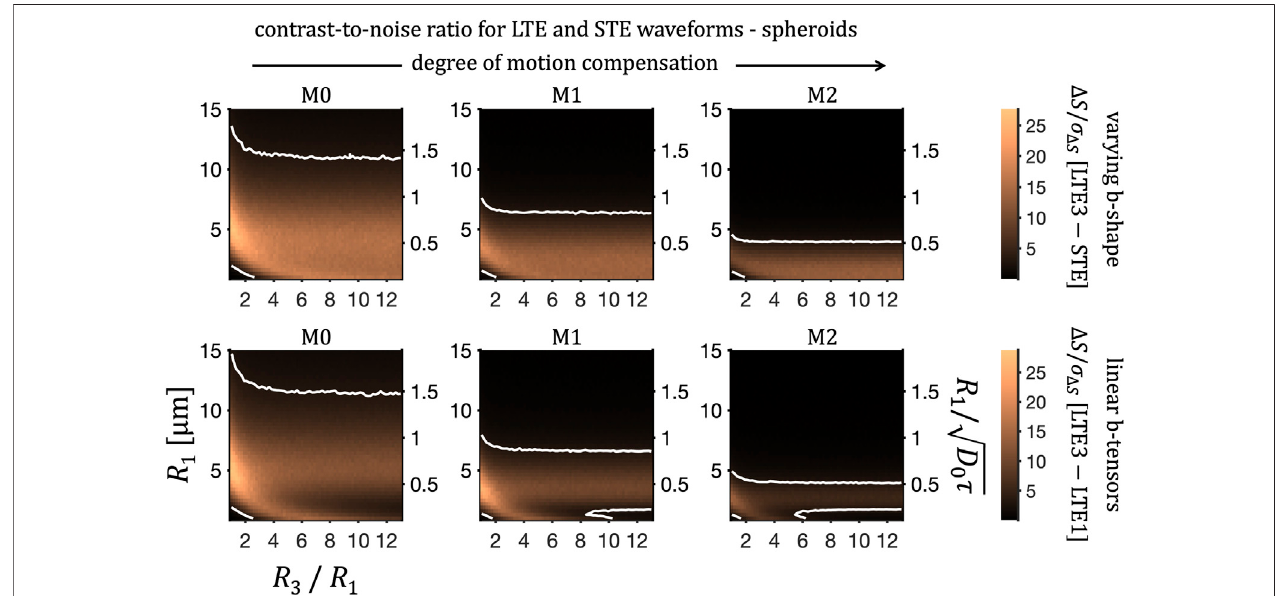
FIGURE 13| Size sensitivity for spheroidalporesat SNR =50. Contrast-to-noise ratio, Δ S / σ Δ S at b = 2 ms/ μ m 2 (as in Figure 12 ) and for f R = 0.5 is shown for M0-, M1-, and M2- (left to right) LTE and STE waveforms as a function of semi-axis R 1 = R 2 and ratio R 3 / R 1 . Two common colour scales are used to show contrast-to-noise ratios for rotation-averaged signals from LTE3 and STE (top row) and from LTE1 and LTE3 (bottom row). Contour lines indicate Δ S / σ Δ S = 3.